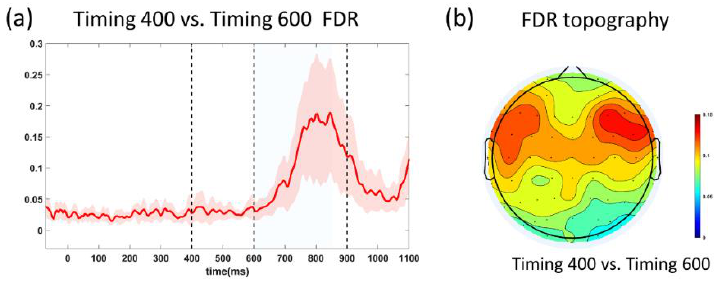
Figure 4. ( a ) FDR profiles; the blue shadow covering 600~850 ms (shadowed area) corresponded to the selected periods of FDR topography. The shadow in the figure indicated the standard deviation of each time point. ( b ) FDR topography of the period 600~850 ms.